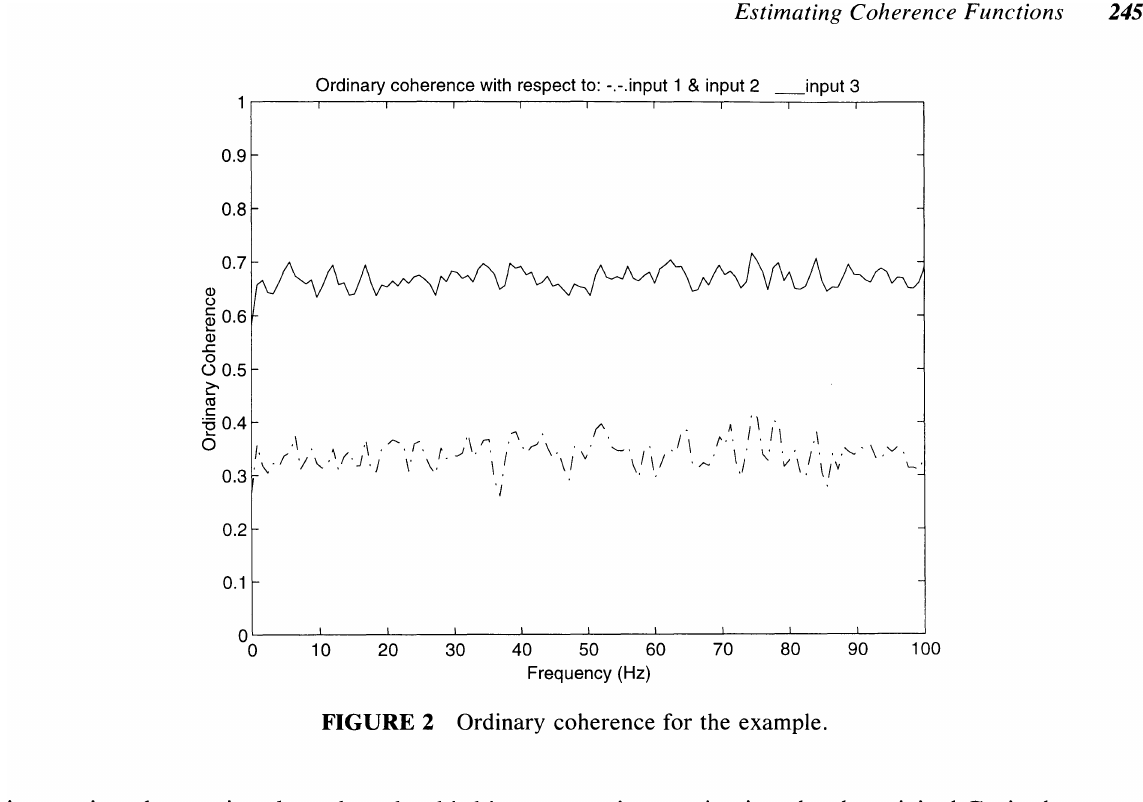
FIGURE 2 Ordinary coherence for the example.